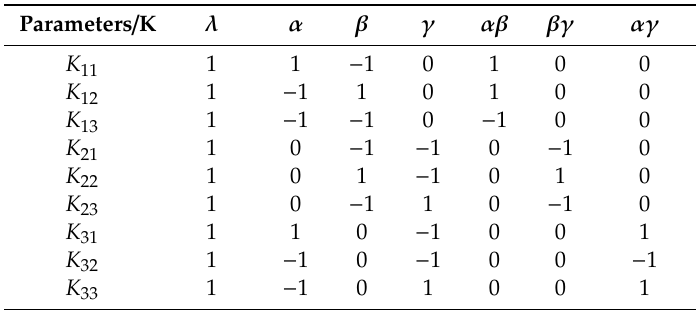
Table 6. The derivatives of the model cell probabilities are stored in the below 9 × 7 derivative matrix X. Each row captures the parameters present in an expected cell probability K ij of one of the three phenotypes j in cross i (Table 4). The X matrix captures the structure of the model. Dropping / adding columns corresponds to dropping / adding parameters in a